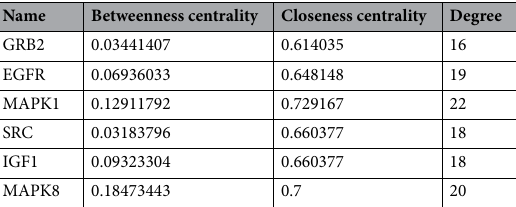
Table 2. Hub genes in NSCLC treated